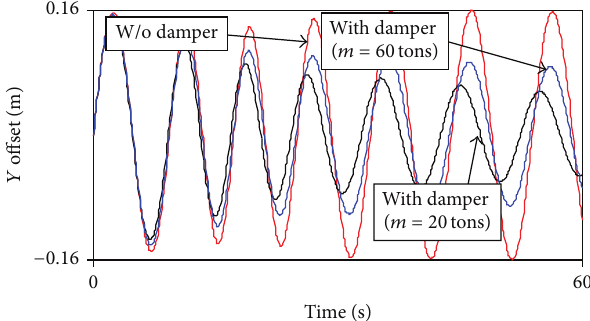
Figure 8: Effect of mass variance on the spreader 𝑌 -offset.